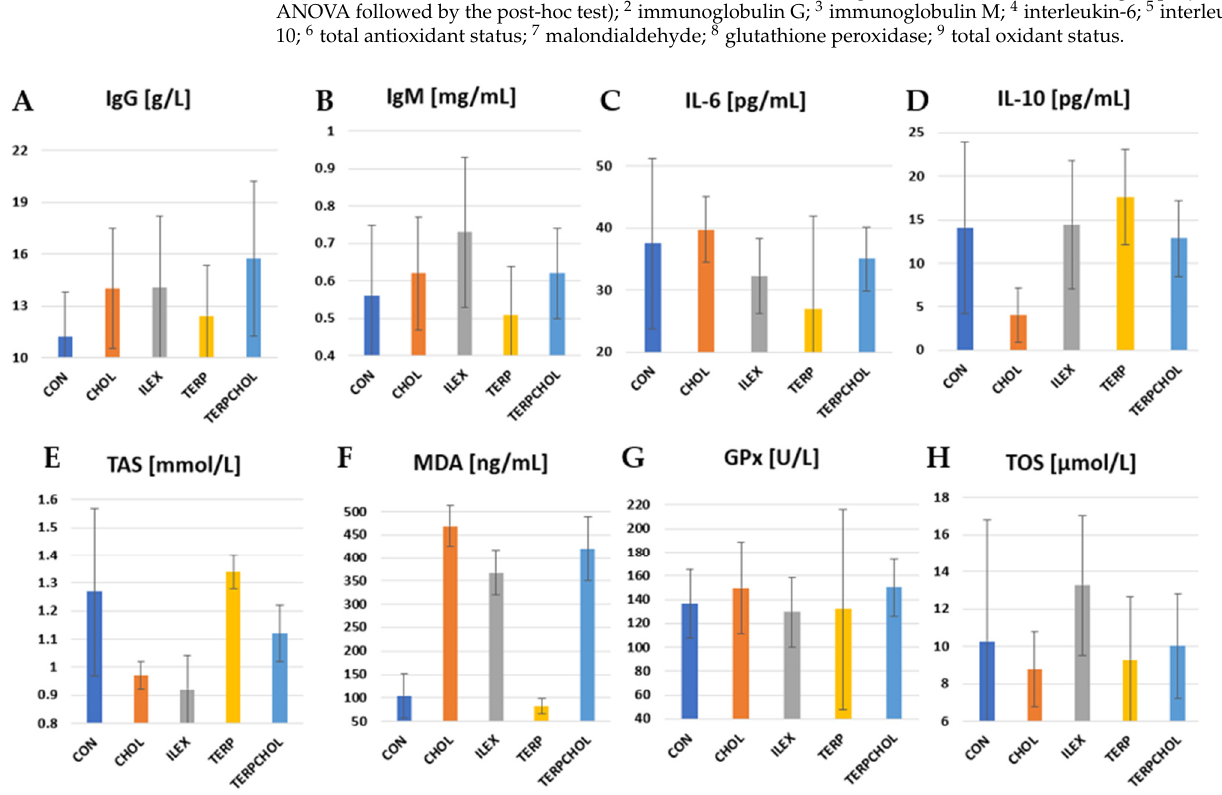
Table 9. Effects of I. aquifolium and terpenoids on immunological and antioxidant parameters in normal or hyperlipidemic Wistar rats. CON